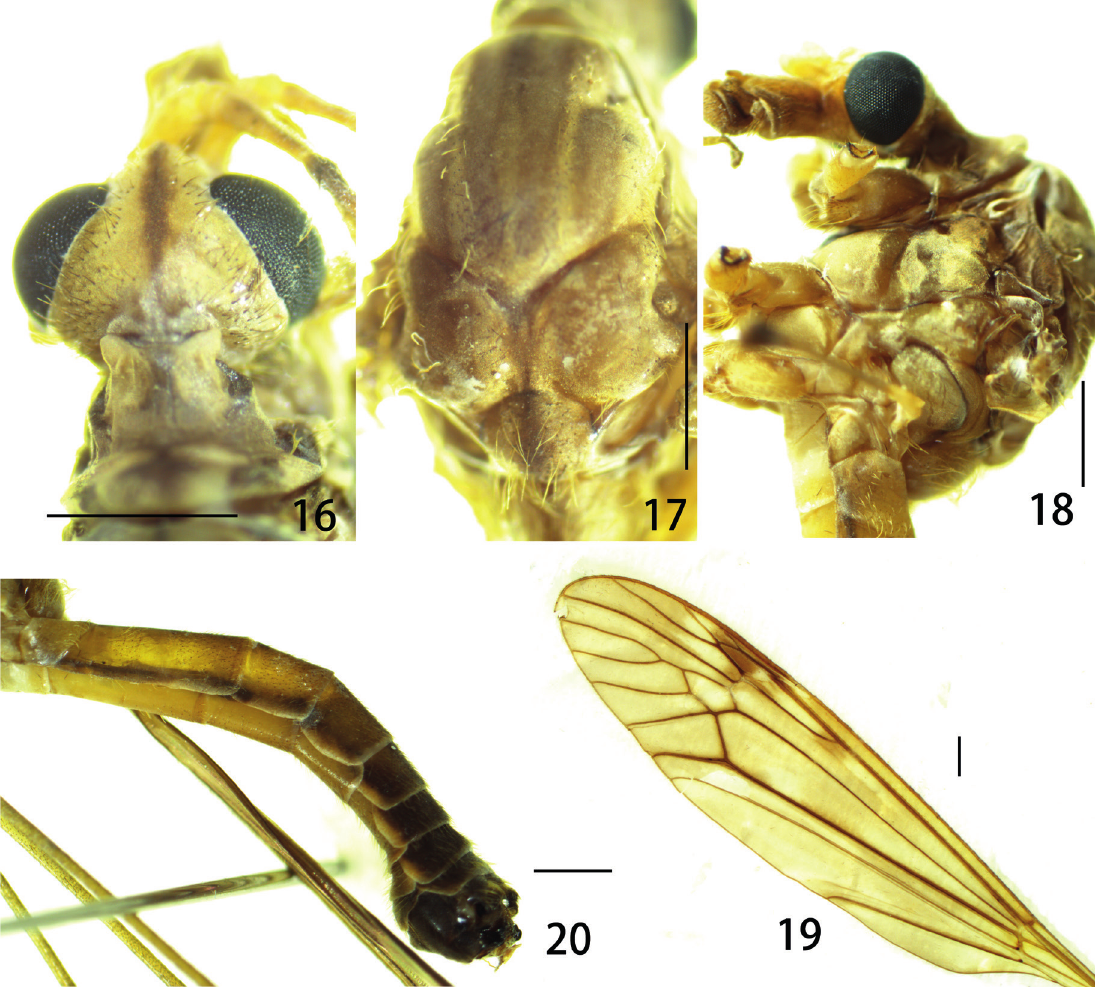
Figs 16–20. Tipula ( Vestiplex ) medialobata sp. nov., ♂ , holotype (coll. Inse-YN0501). 16 . Head, dorsal view. 17 . Thorax, dorsal view. 18 . Thorax, lateral view. 19 . Wing. 20 . Abdomen, lateral view. Scale bars = 1.0